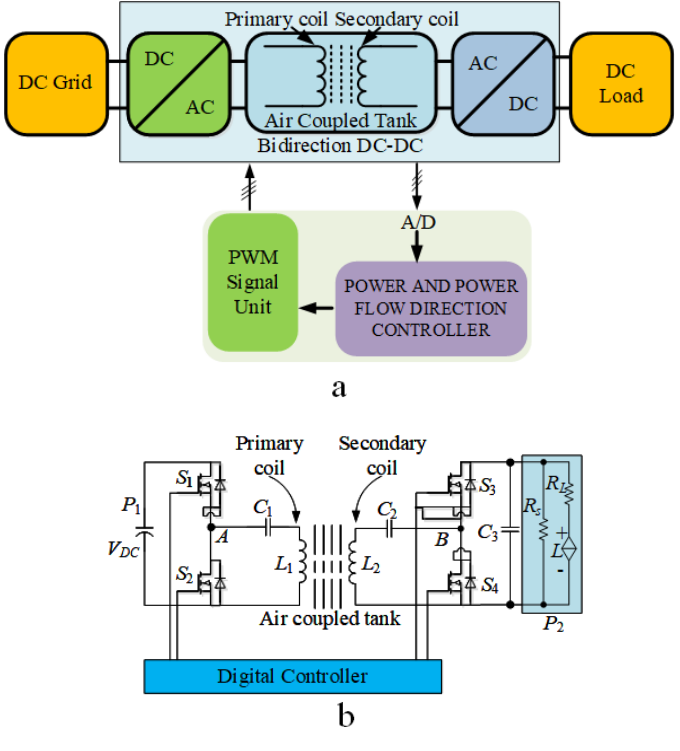
Figure 1. The proposed DC transformer: ( a ) System structure ( b ) System